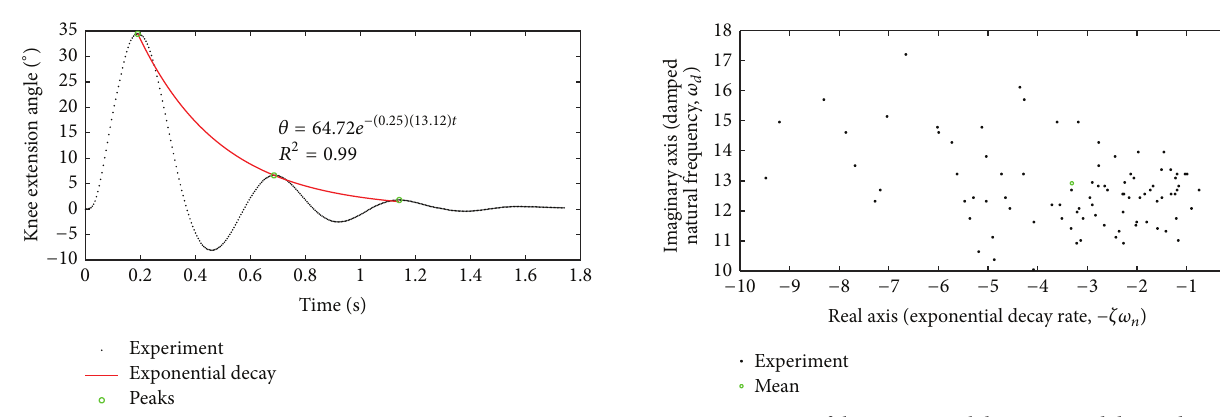
Figure 1: Sample patellar reflex response with the oscillation peaks of the extension angle identified and best-fit, exponential decay curve found.